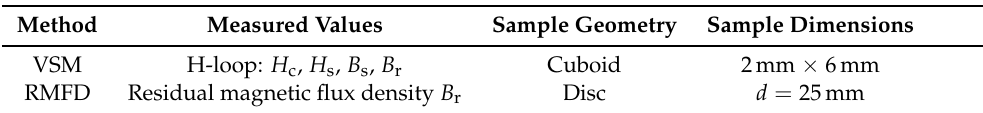
Table 4. Selected methods for measuring the magnetic material properties by the obtained values and sample geometries (third dimension depends on sheet metal thickness).